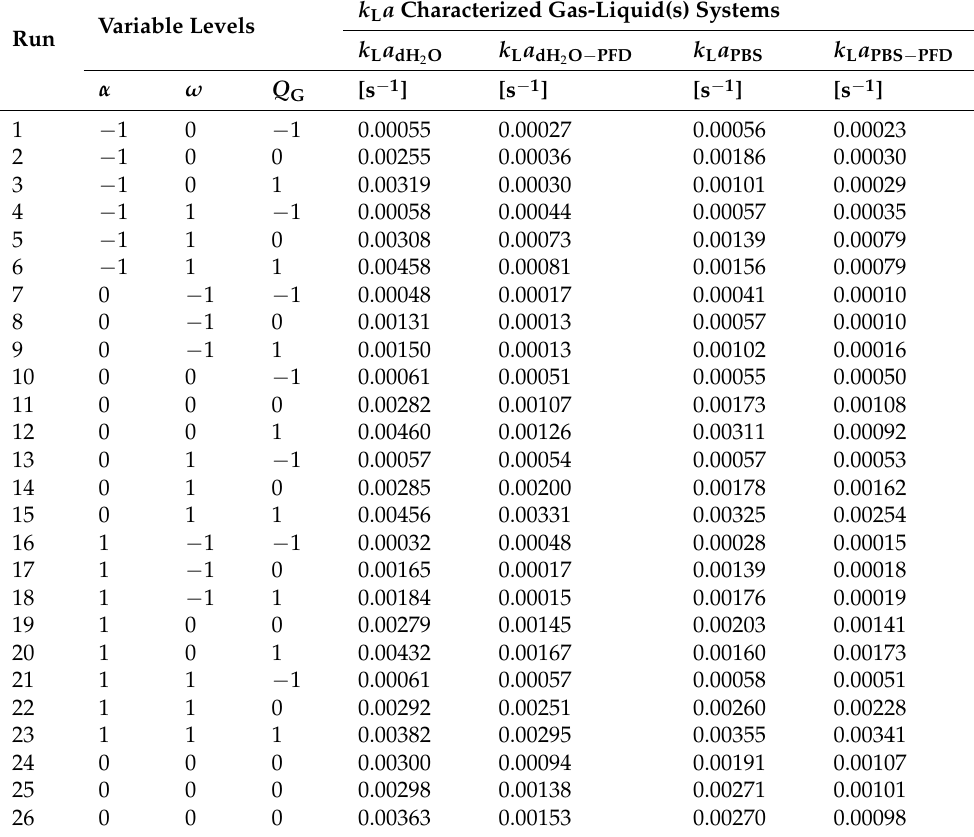
Table 2. Variable levels were introduced to the BBD with three operation parameters ( α , ω , Q G ) to determine the k L a coefficient for four independently studied gas-liquid(s)